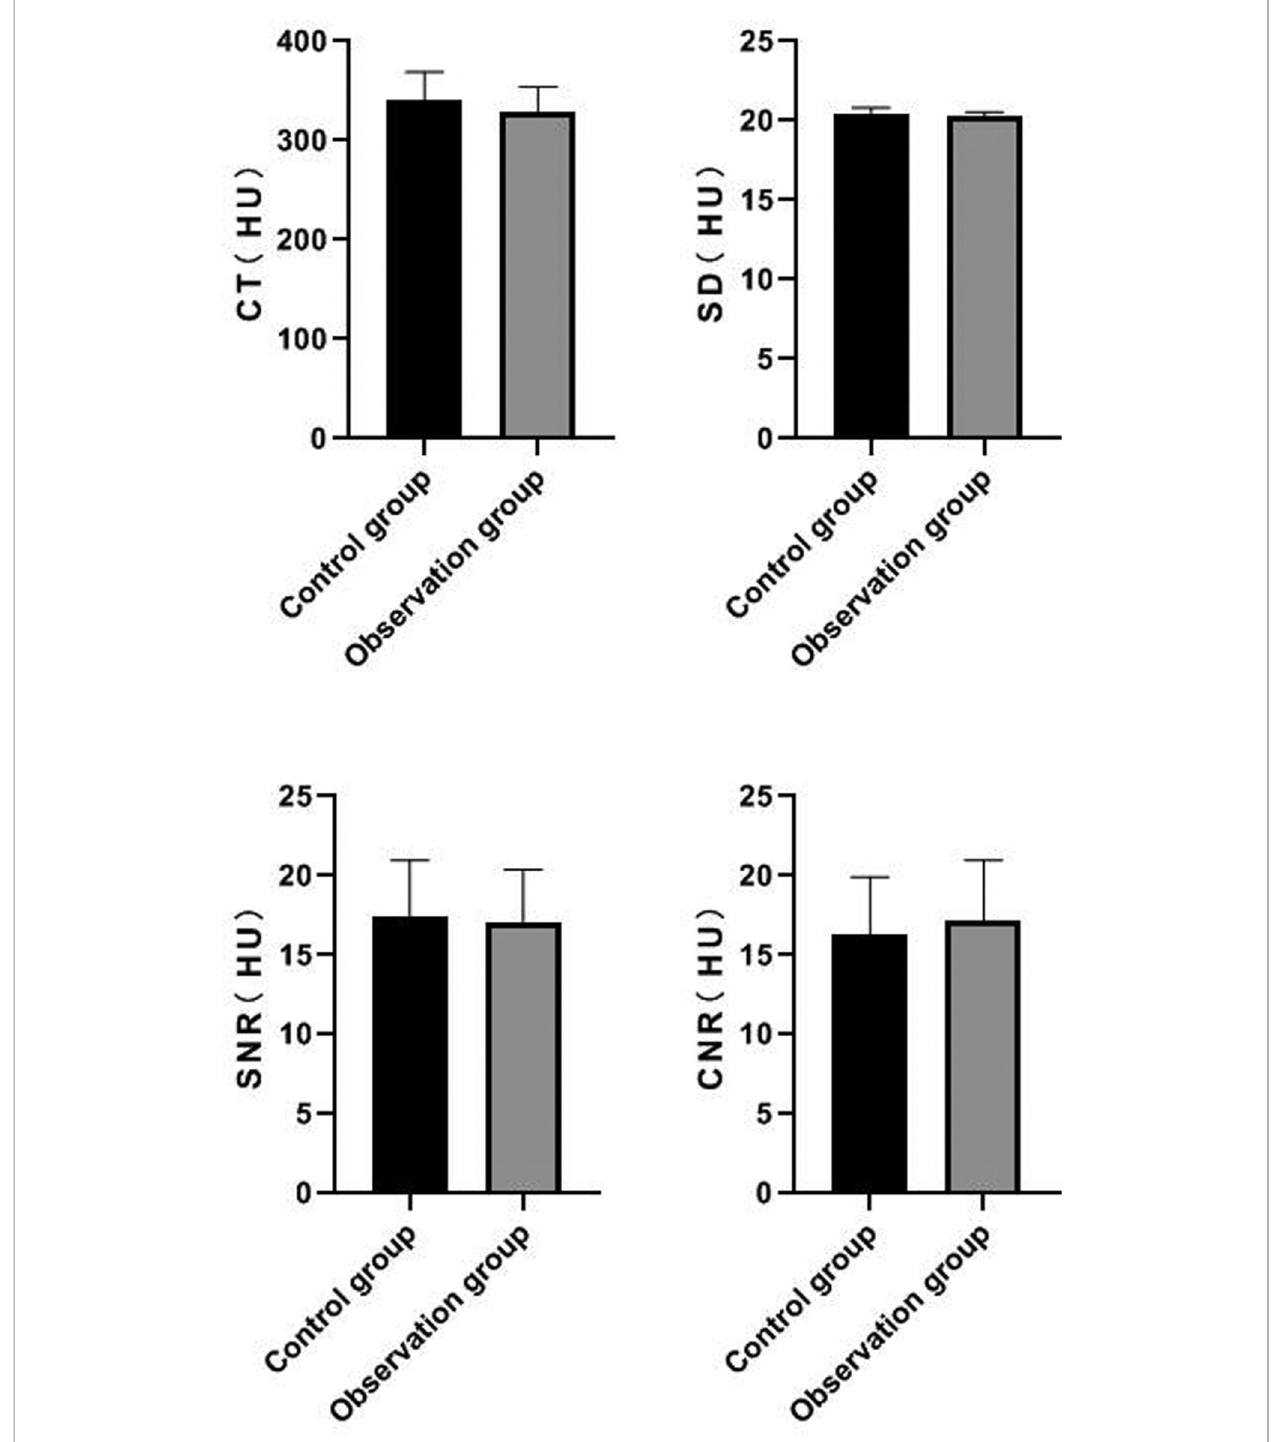
FIGURE 4 | Comparison of measured values of posterior tibial artery segment between the two